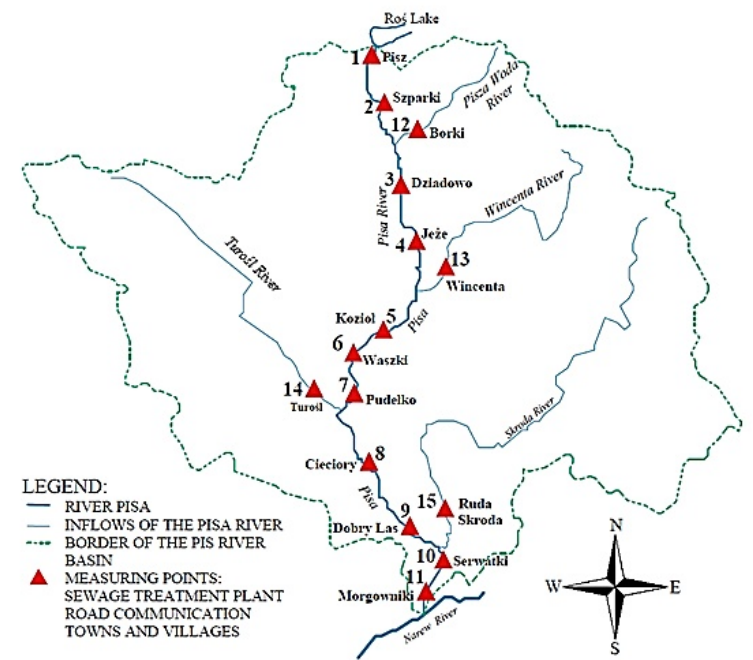
Figure 1. Research facility—the Pisa River and its tributaries.